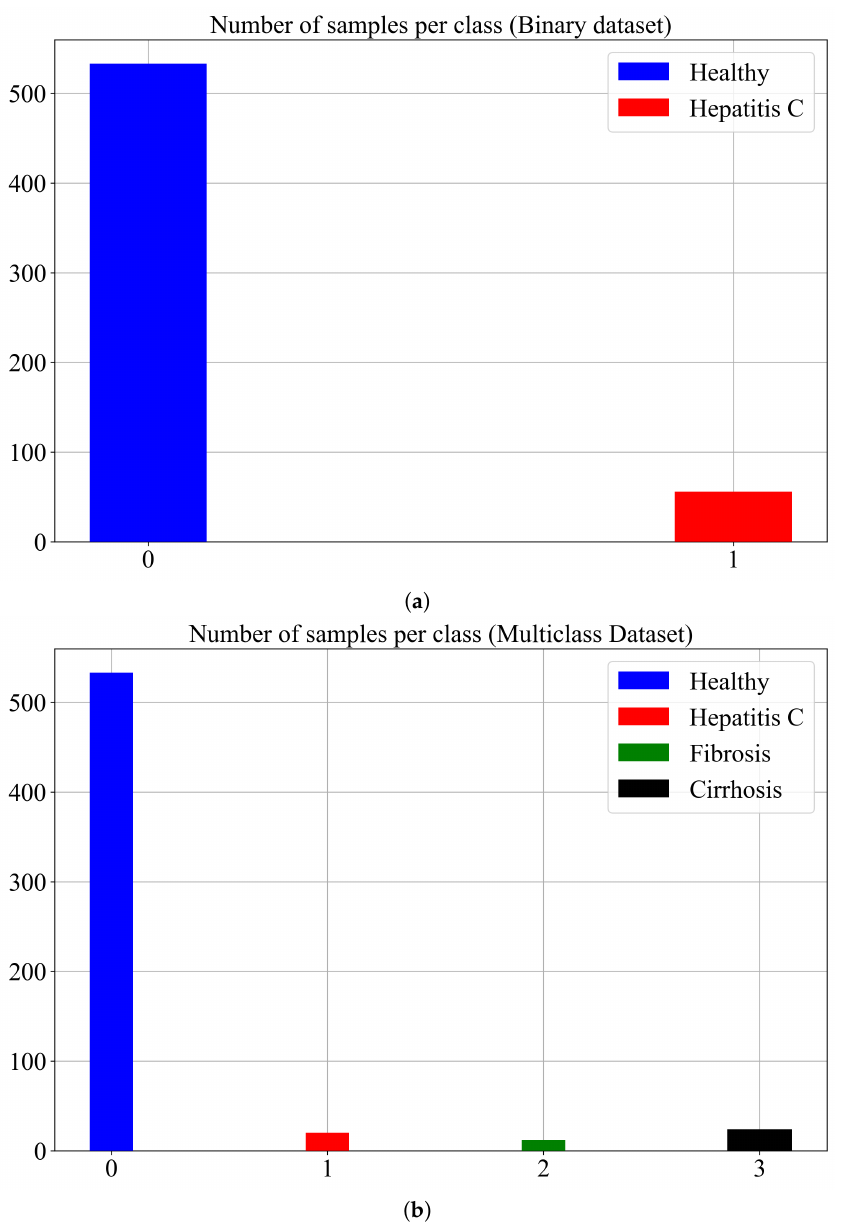
Figure 3. The number of samples per class in binary dataset and multiclass dataset. ( a ) Binary case; ( b ) Multiclass